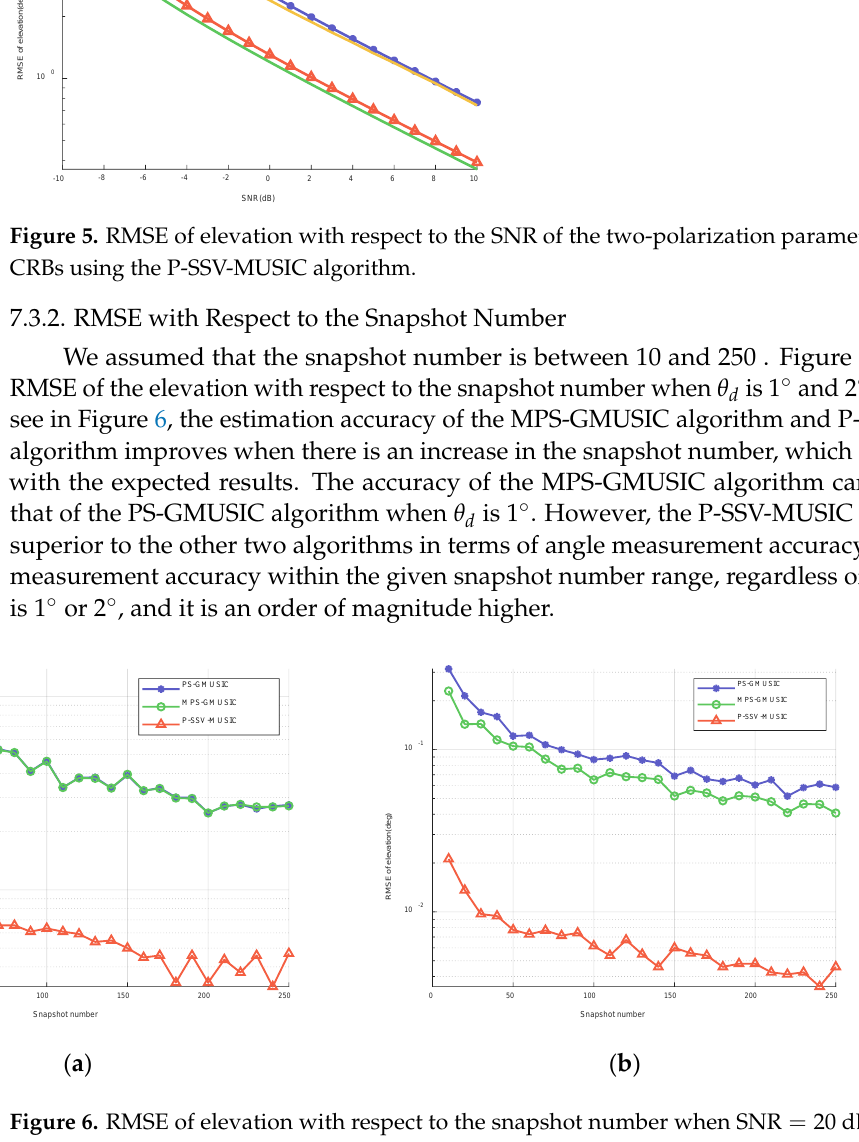
( b ) Figure 7. RMSE of elevation with respect to the phase aberration when SNR 20 dB = and T 100 = : ( a ) 1 d θ =  ; ( b )